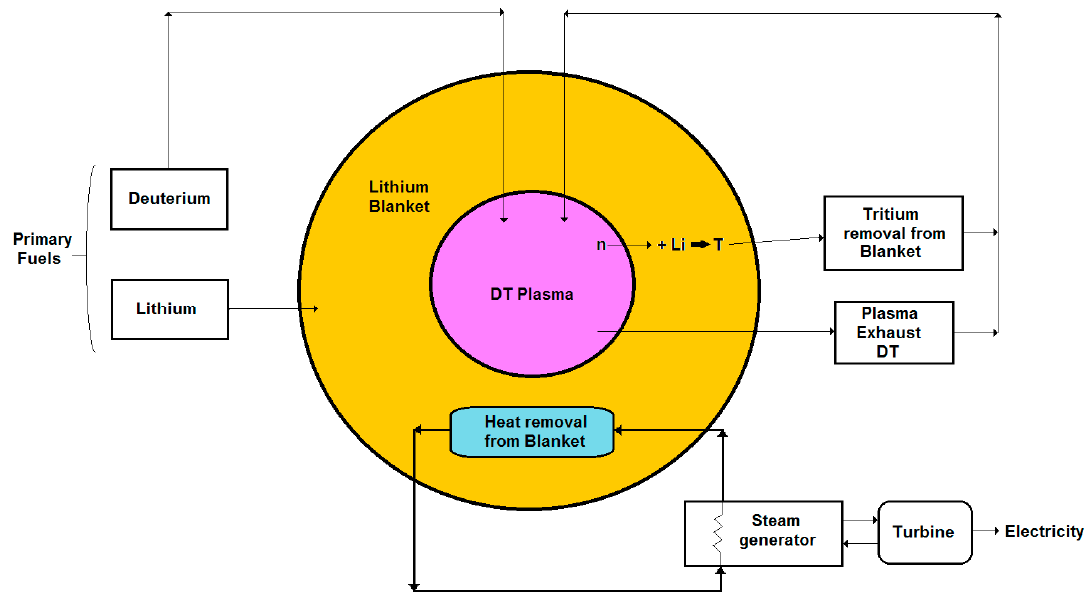
Figure 1. Schematic of a fusion power plant.